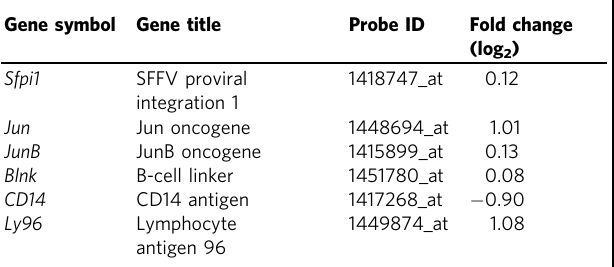
Table 3 Unaffected PU.1 Target